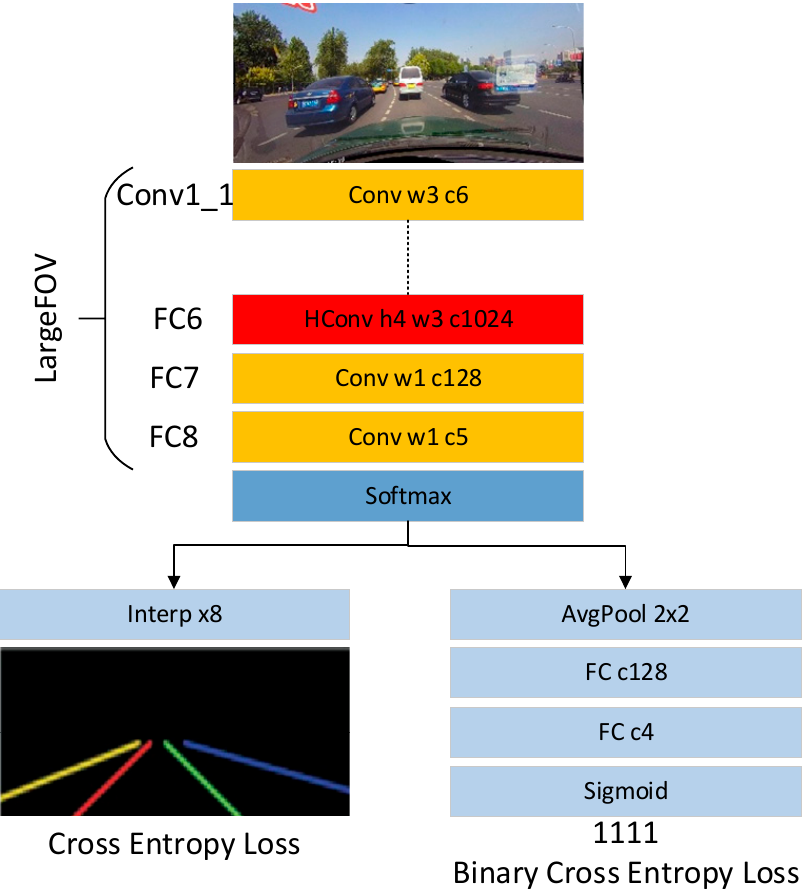
Figure 1. SCNN backbone network structure diagram.